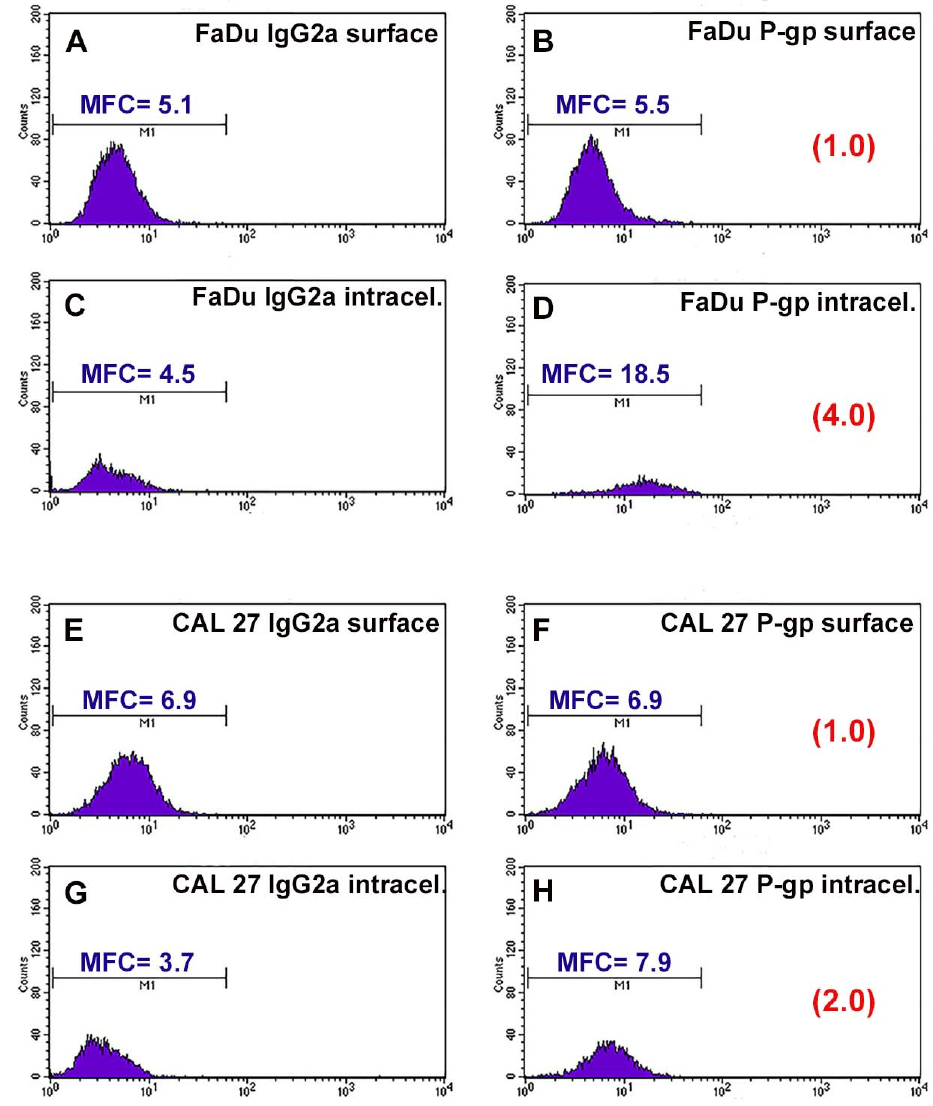
Figure 1. Flow cytometric profiles of surface and intracellular P-gp expression in FaDu and CAL 27 cells. ( A ) FaDu cells labeled with IgG2a globulin on cell surface; ( B ) FaDu cells labeled with MRK16 MAb on cell surface; ( C ) FaDu cells intralabeled with IgG2a globulin; ( D ) FaDu cells intralabeled with MRK16 MAb. ( E ) CAL 27 cells labeled with IgG2a globulin on cell surface; ( F ) CAL 27 cells labeled with MRK16 MAb on cell surface; ( G ) CAL 27 cells intralabeled with IgG2a globulin; ( H ) CAL 27 cells intralabeled with MRK16 MAb. The intensity of the surface P-gp signal was negative on both cell lines, whereas at the intracellular level, FaDu cells ( D ) expressed a higher intensity value than CAL 27 ones (H).